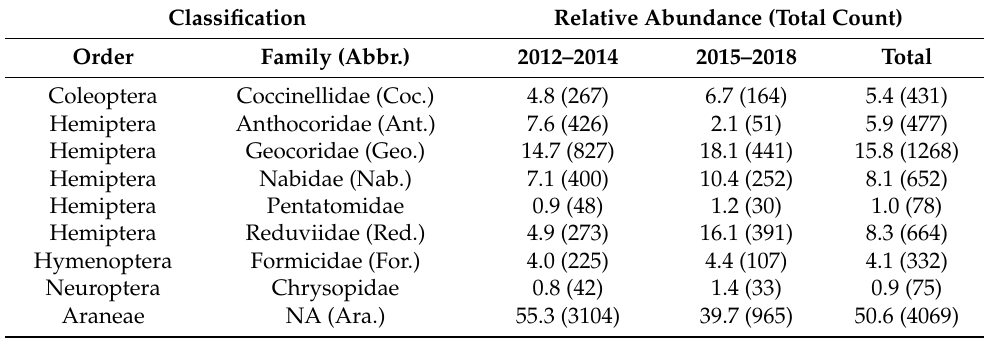
Table 1. Relative abundance and total count data for collected predator groups,